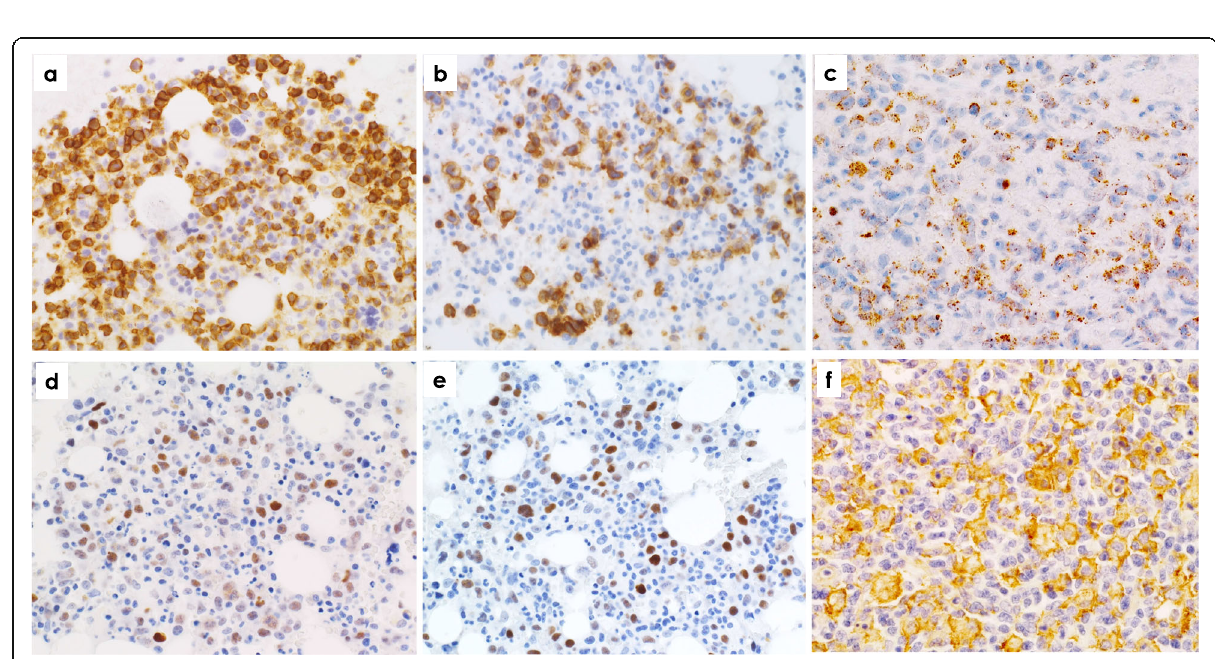
Fig. 2 a Numerous CD8 + medium-sized and large lymphocytes in bone marrow clot sample from patient No. 3. b Scattered infiltrate of CD8 + medium-sized and large lymphocytes in bone marrow from patient No. 12. c Scattered and clustered TIA1 + large lymphocytes in hepatic lobules of patient No. 11. d , e pSTAT3 + and CMYC + atypical lymphocytes in bone marrow (patient No. 4). f Scattered histiocytes/dendritic cells show strongly positive reaction to PD-L1 (R3 + ) in a lymph node from patient No. 9. ×